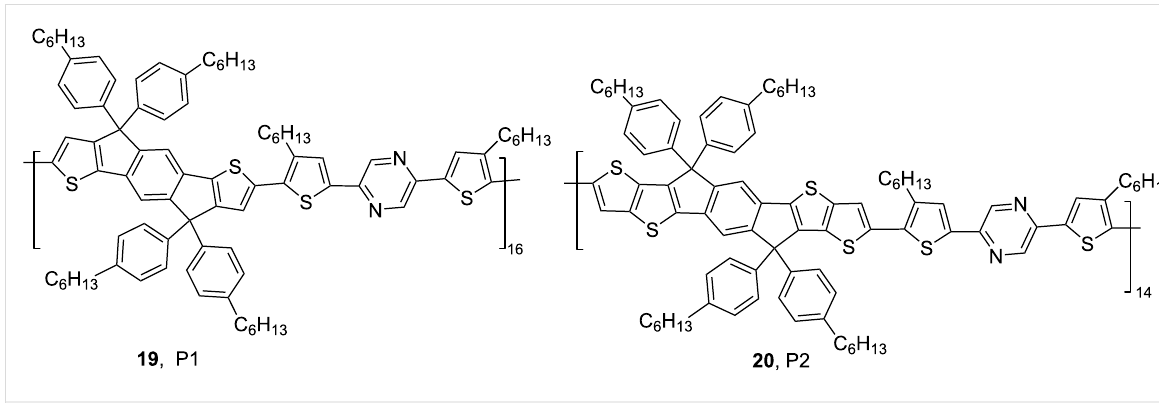
Figure 10: Pyrazine-containing polymers 19 and 20 investigated by Li et al.